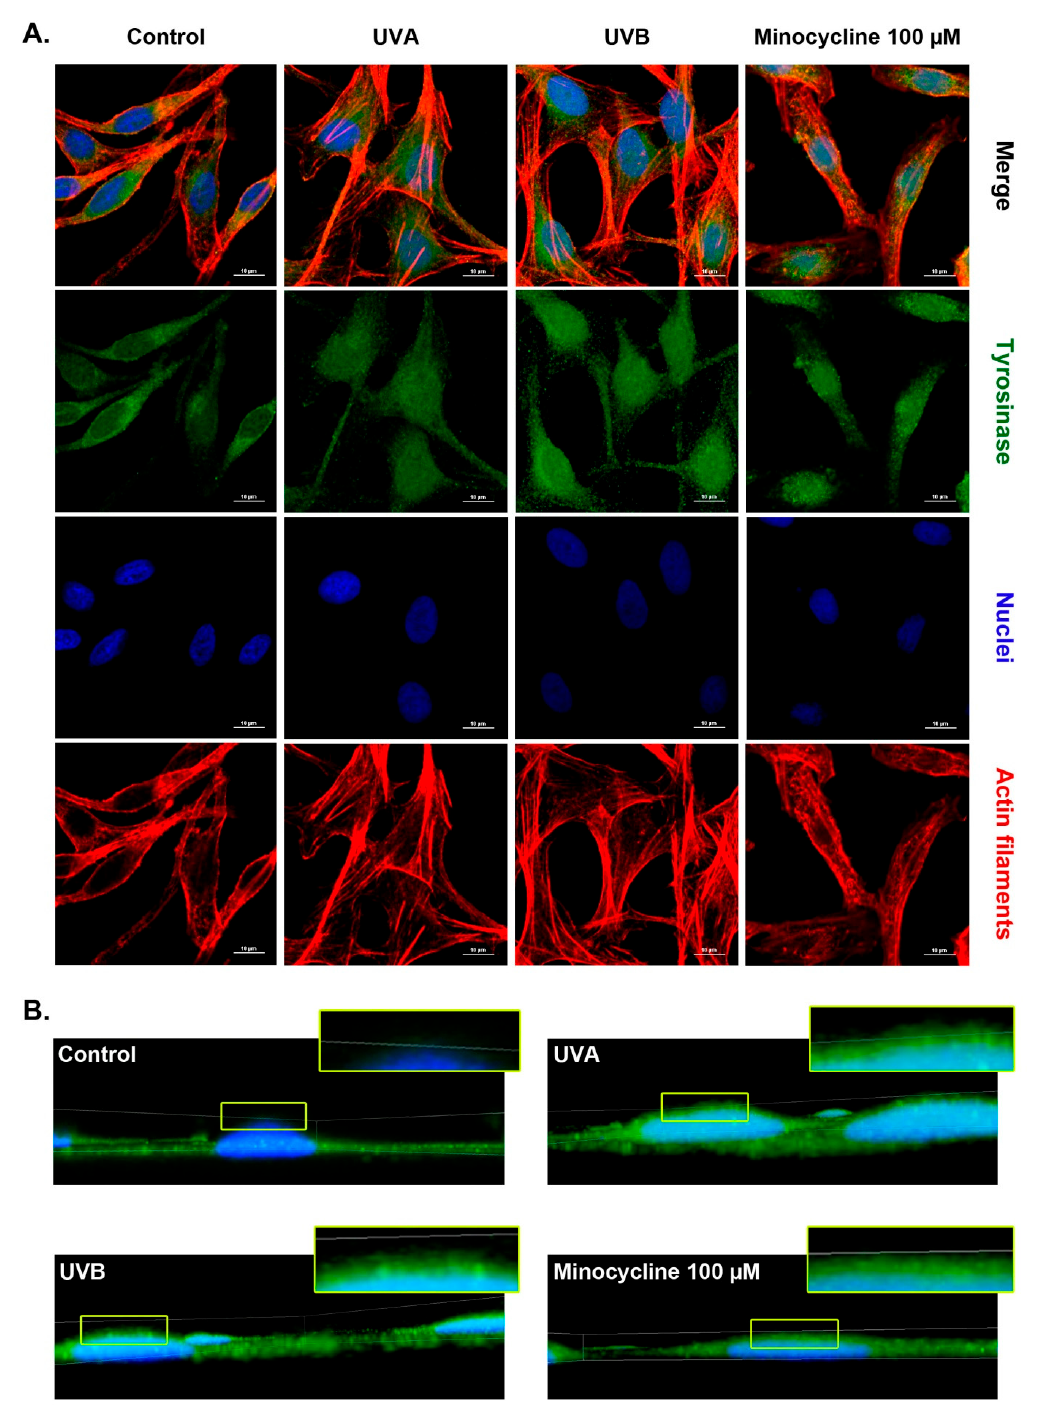
Figure 8. Confocal microscopy imaging of human normal melanocytes treated with minocycline and exposed to UVA and UVB radiation. ( A ) Photographs are presented as separate channels for tyrosinase, nuclei and actin filaments as well as merge images. Scale bar 100 μ m. ( B ) 3D confocal imaging of normal melanocytes treated with minocycline and exposed to UVA or UVB radiation. The presented z-stack reconstructions show DAPI-stained nuclei (blue) and immunolabeled tyrosinase (green).